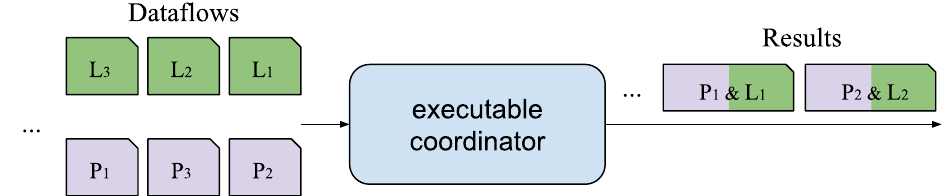
Figure 5. Example for the synchronization of multiple incoming